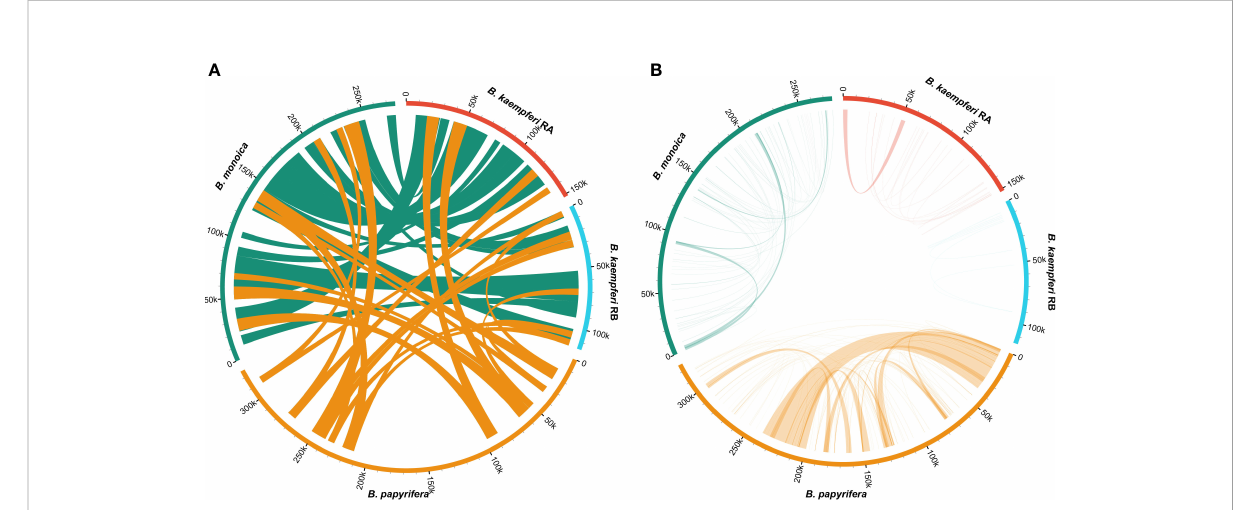
FIGURE 3 Synteny of the mitogenomes. (A) Interspeci fi c synteny indicated by homologous regions longer than 5000 bp. (B) Individual internal synteny indicated by all identi fi ed homologous regions.